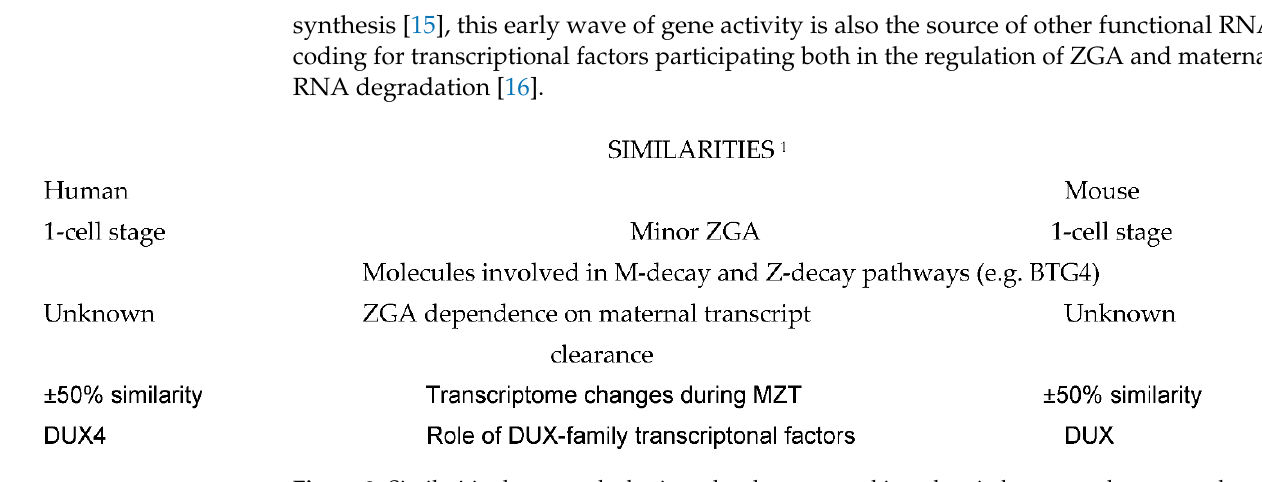
Figure 2. Similarities between the basic molecular events taking place in human and mouse embryos. Explanations: 1 Comparisons are to be made taking into account the differences in ZGA timing. Abbreviations: ZGA: zygote gene activation; MZT: maternal ‐ to ‐ zygotic transition of embryo developmental control; M ‐ decay and Z ‐ decay pathways: pathways of maternal transcript elimination controlled by maternal and zygotic transcripts, respectively. DUX: double homeobox.